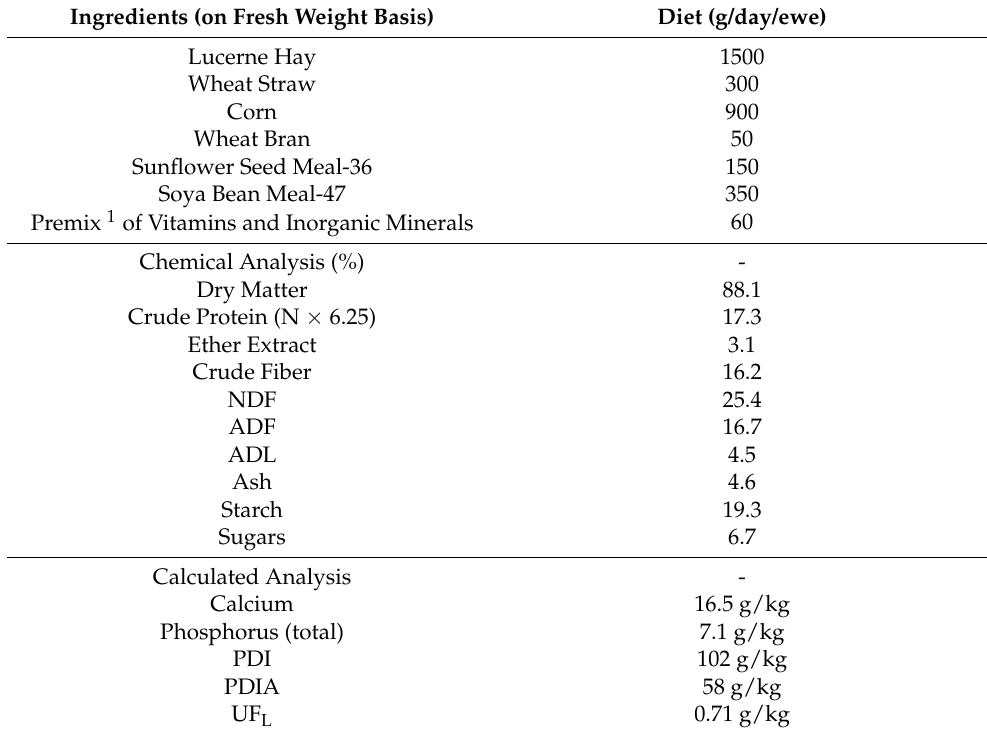
Table 1. Daily ingredient allowance and chemical composition of the diet offered to dairy ewes 1 . Ingredients (on Fresh Weight